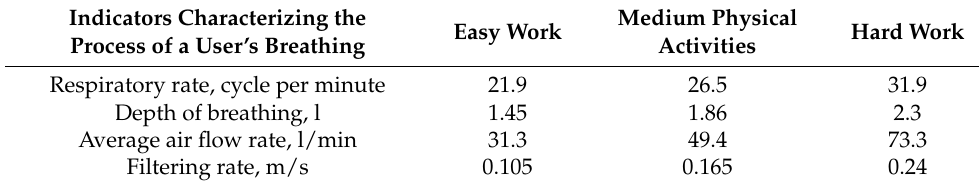
Table 2. Parameters of the filtering material Elephlen.